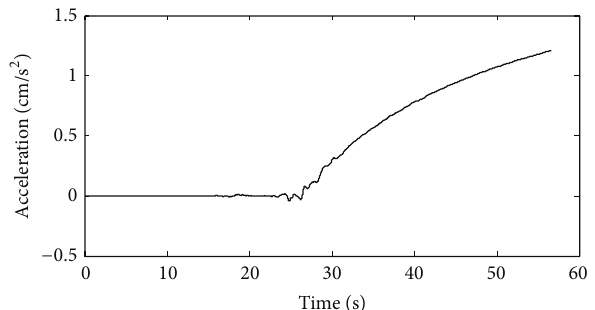
Figure 19: Cumulative acceleration time history.